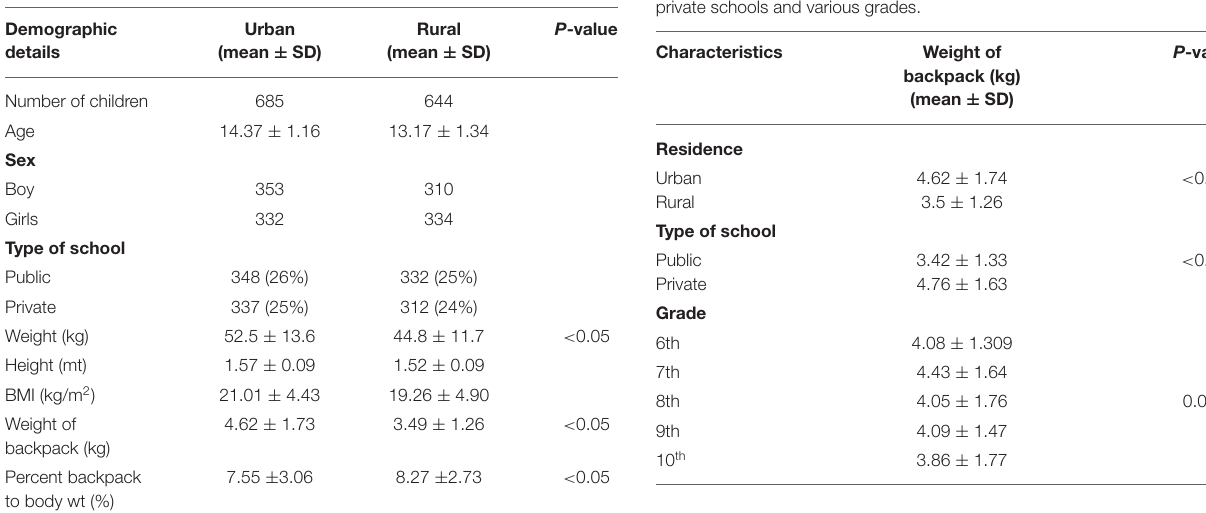
TABLE 1 | Demographic details of school children. TABLE 2 | Association of backpack weight among urban vs. rural, public vs. private schools and various grades.